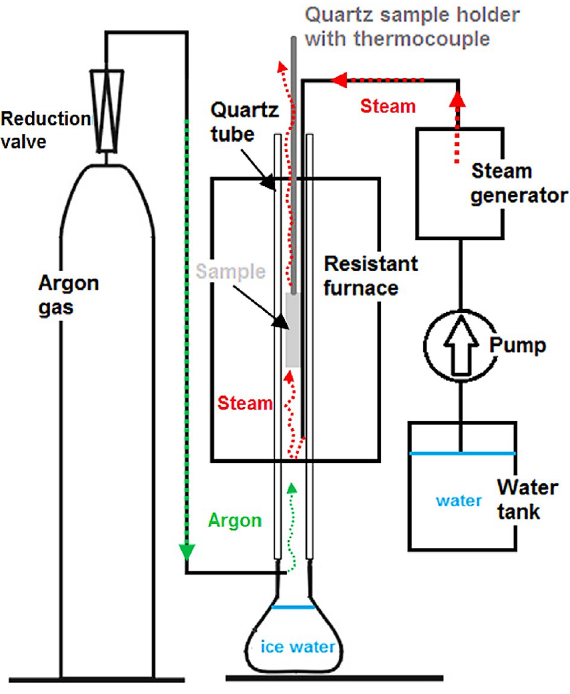
Figure 5. The scheme of high-temperature oxidation